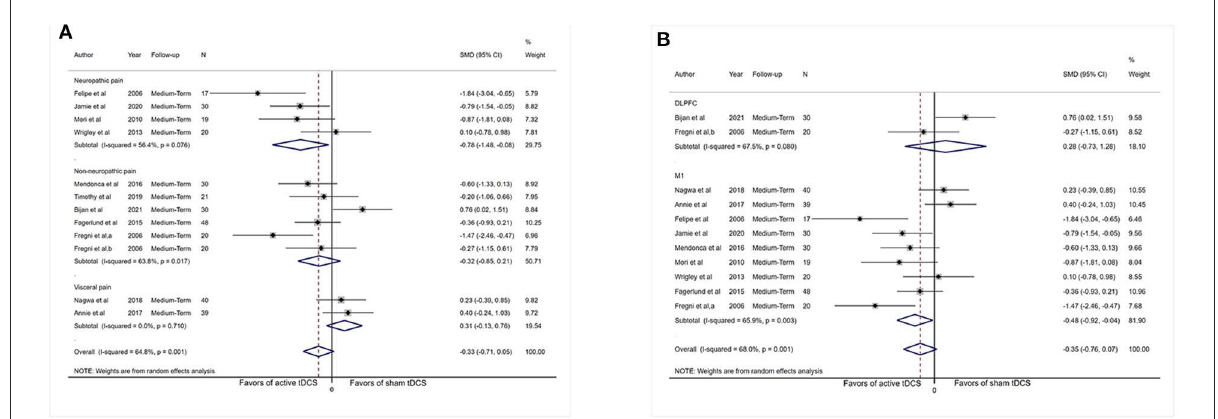
FIGURE6 Forest plot showing SMDs in pain intensity scores from data of medium-term studies. (A) Sub-analysis of pain intensity scores by different types of chronic pain patients. (B) Sub-analysis of pain intensity scores comparing the stimulation of M1 with DLPFC. CI, confidence interval; SMD, standard mean difference; tDCS, transcranial direct current stimulation; M1, motor cortex; DLPFC, dorsolateral prefrontal cortex; a, motor cortex; b, dorsolateral prefrontal cortex.